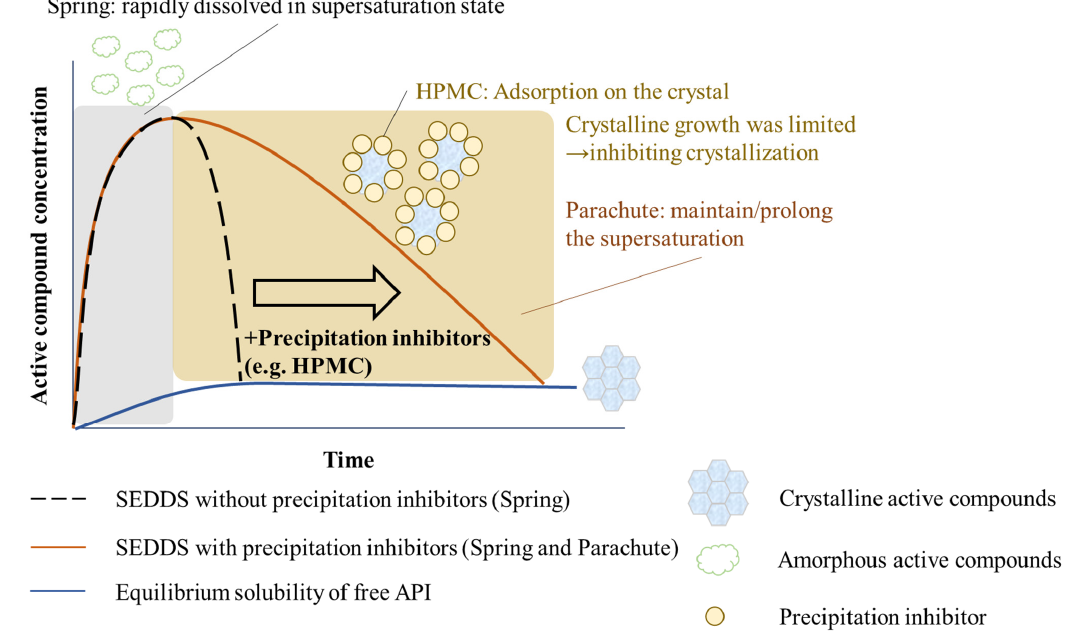
Figure 13. The mechanism of the “Spring and Parachute”.